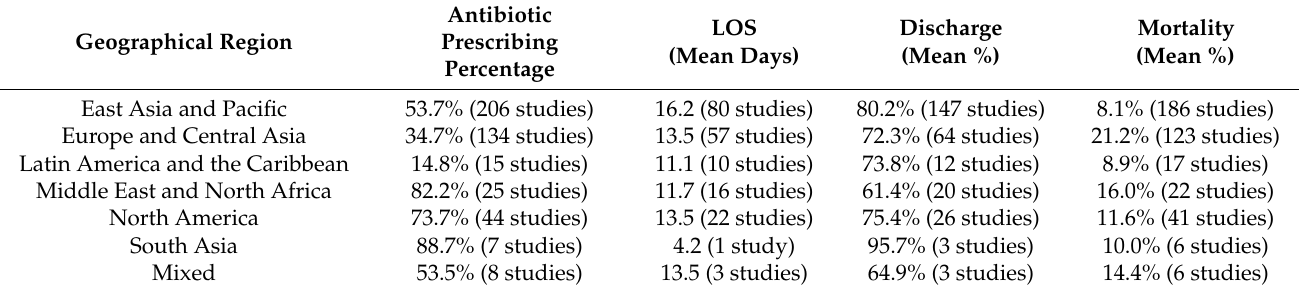
Table 7. Geographical region, antibiotic prescribing and health outcomes in COVID-19